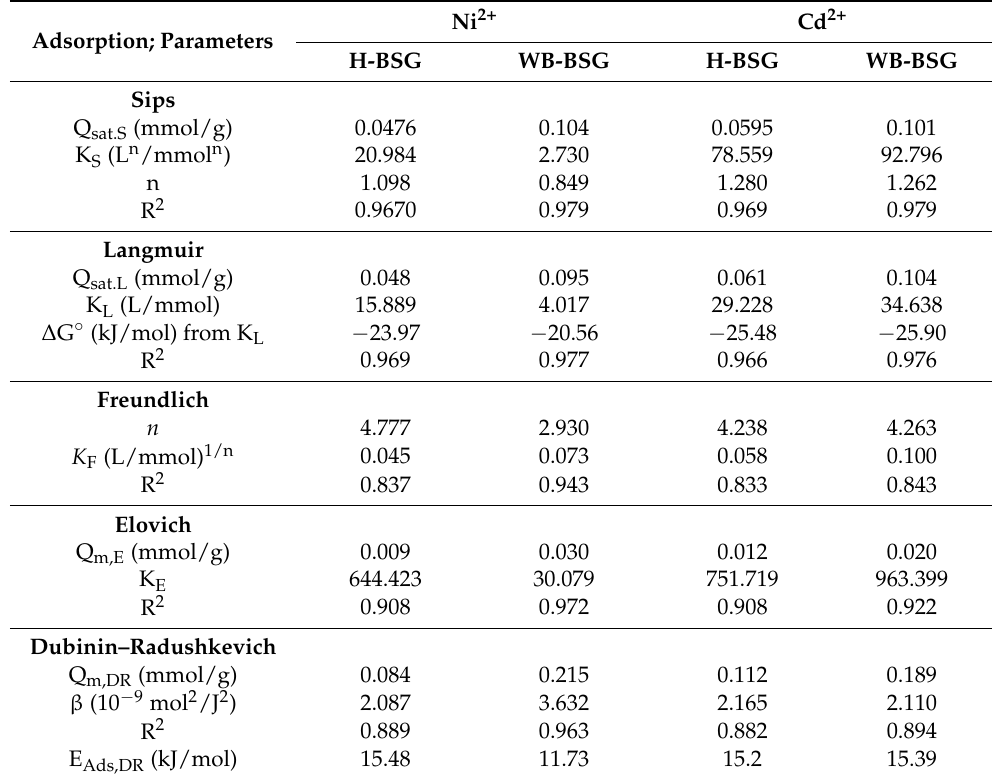
Table 5. Fitting parameters for Ni 2+ and Cd 2+ adsorption onto H-BSG and WB-BSG for Sips, Lang- muir, Freundlich, Elovich and Dubinin-Radushkevich isotherm models. Data from batch experiments as presented in Figure 9. The graphical fitting comparisons are given in Figures S21 and